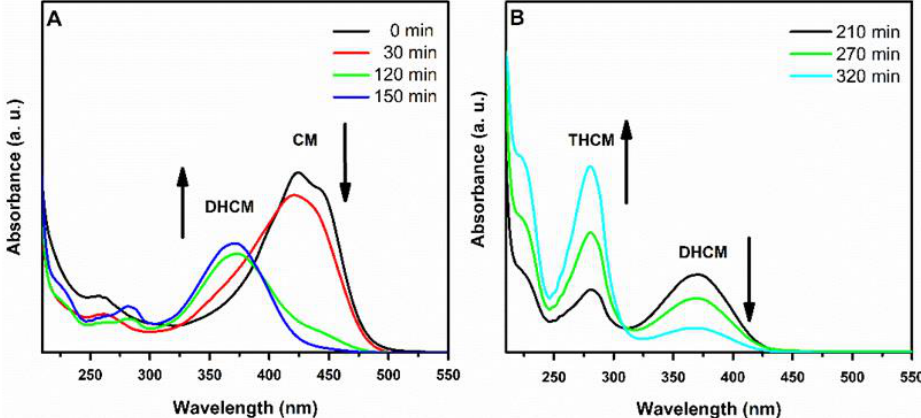
Figure 4. Monitoring of the CM reduction process over time (0–150 min, panel ( A ); 210–320 min, panel ( B )) by UV-Vis spectroscopy.